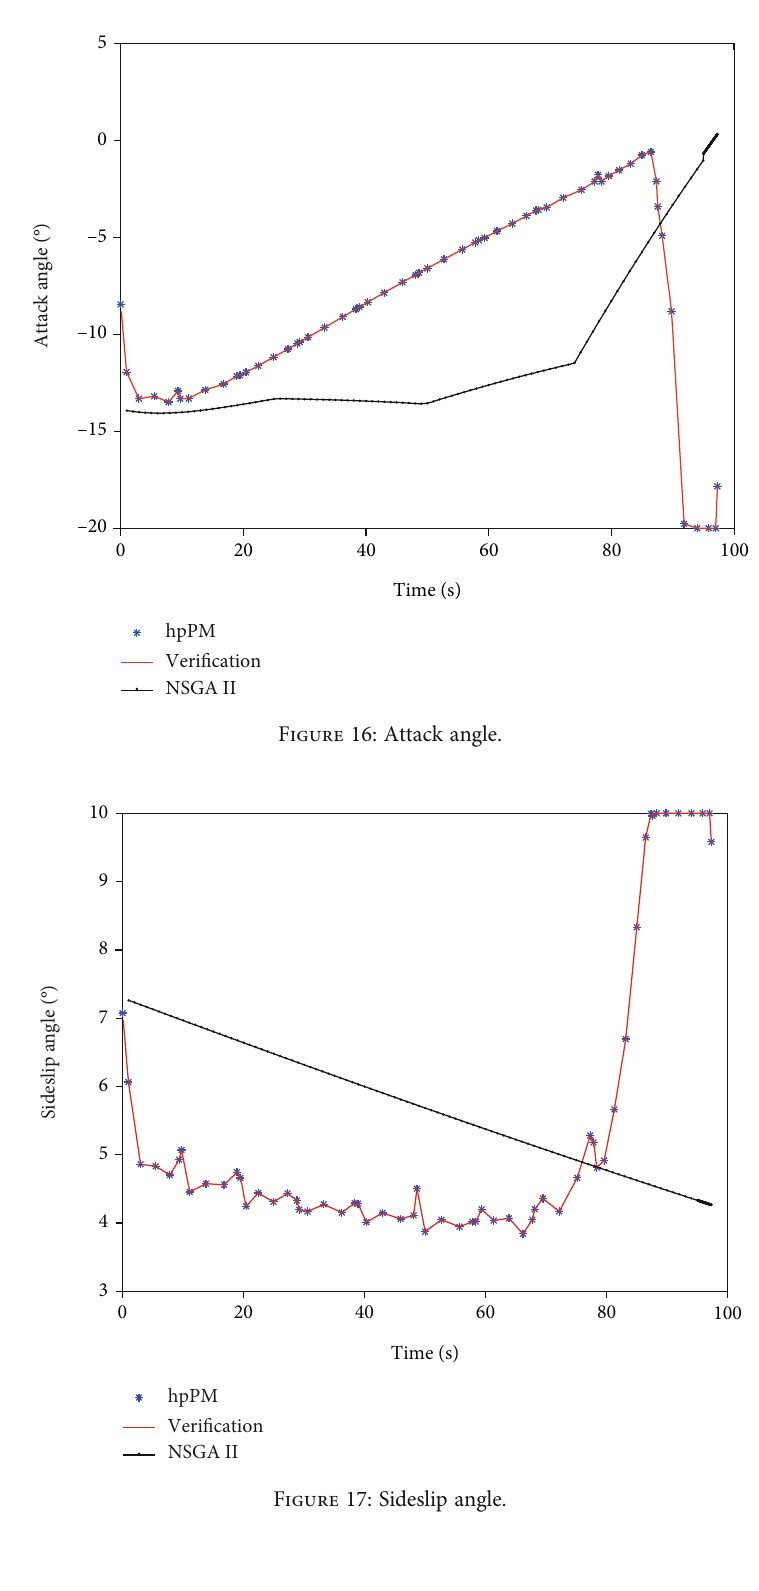
Figure 17: Sideslip